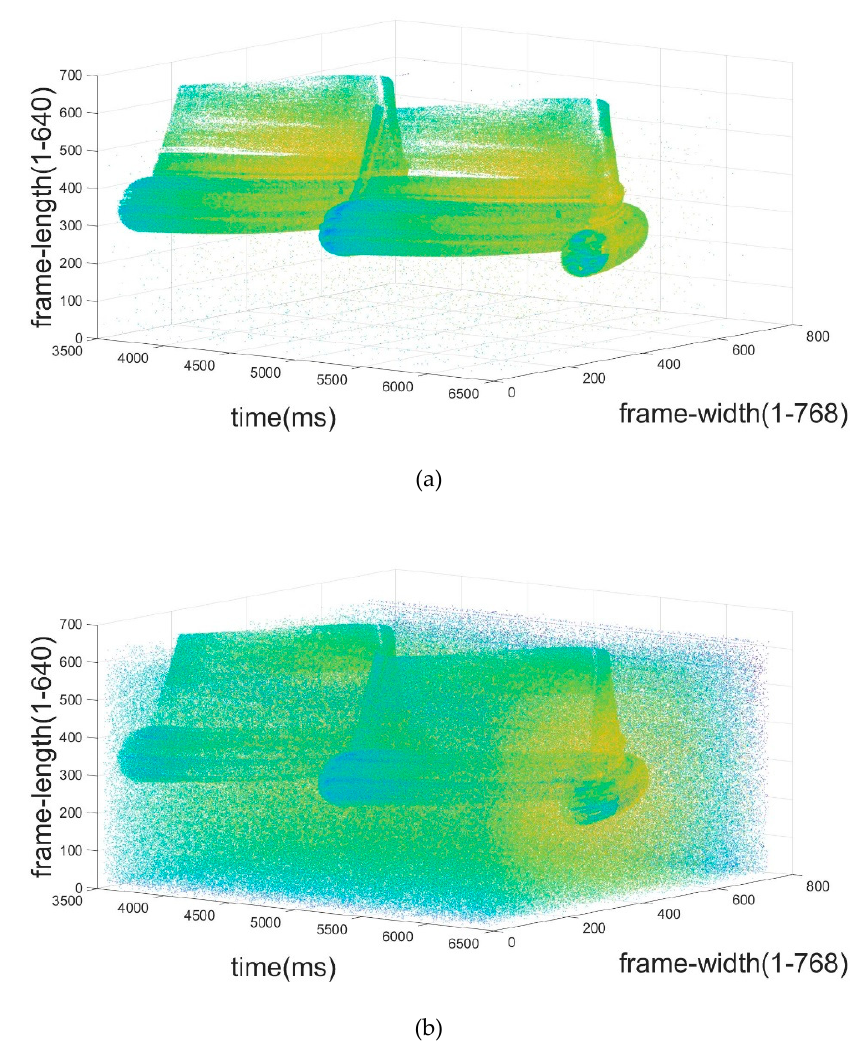
Figure 9. Filtering result of Khodemoradi ‘s filter: ( a ) is the result of denoising and ( b ) is the filtered noise.